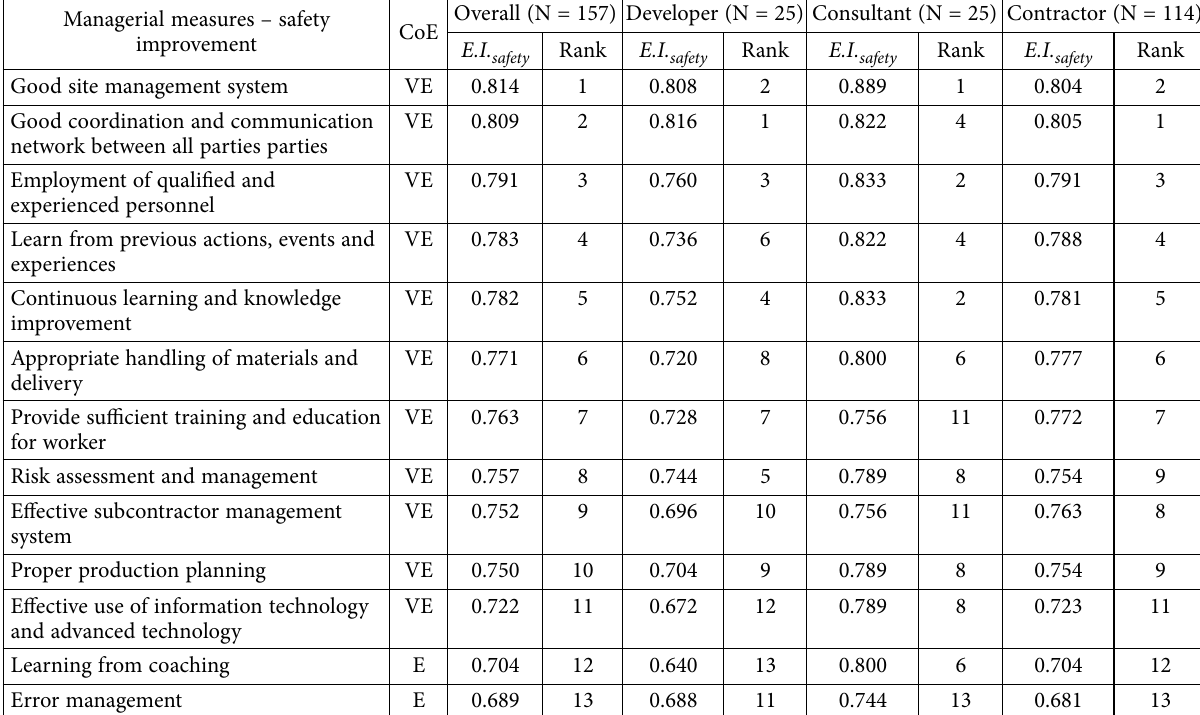
Table 4. Effectiveness index and ranking for safety management